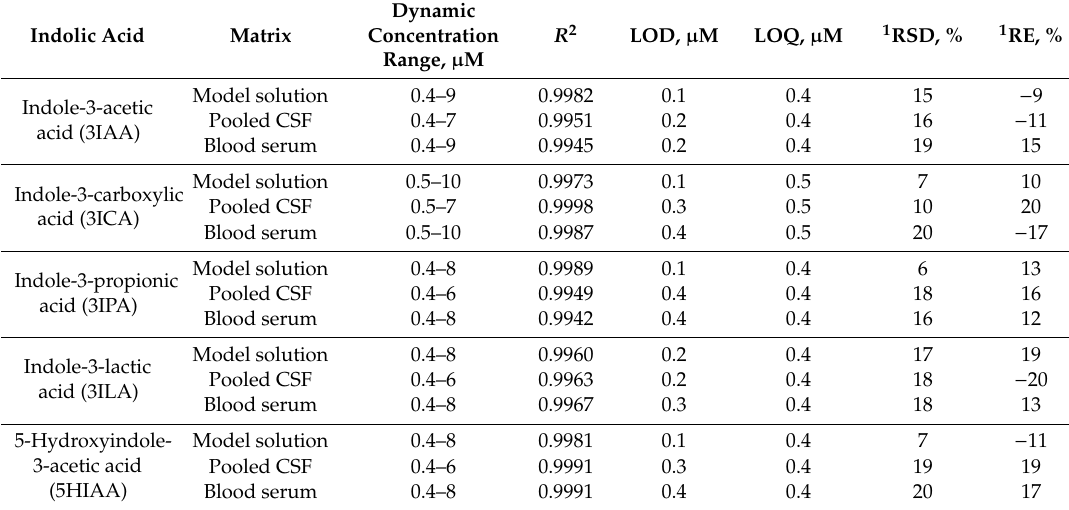
Table 4. Analytical characteristics of the determination of the indolic acids in model solutions, pooled cerebrospinal (CSF) and serum samples ( n = 3, p = 0.95). Dynamic Indolic Acid Matrix Concentration R 2 LOD, µ M LOQ, µ M Range, µ M Model solution Indole-3-acetic acid (3IAA) Model Indole-3-carboxylic acid (3ICA)